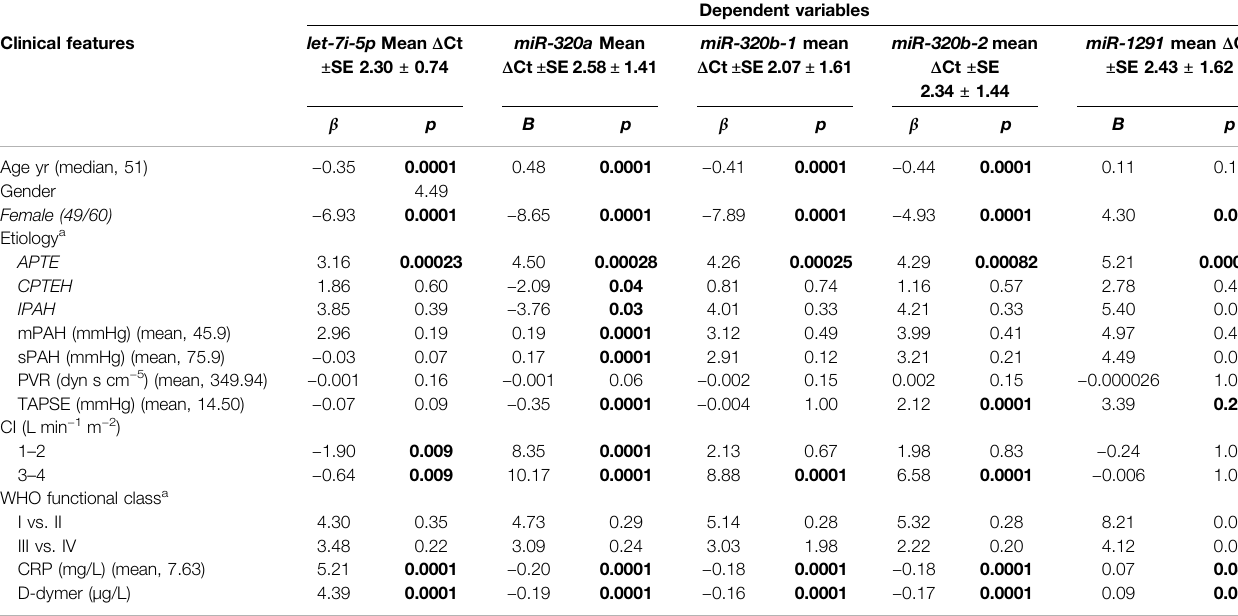
TABLE 3 | Association between baseline and c linical characteristics of the patients and miRNA microarray